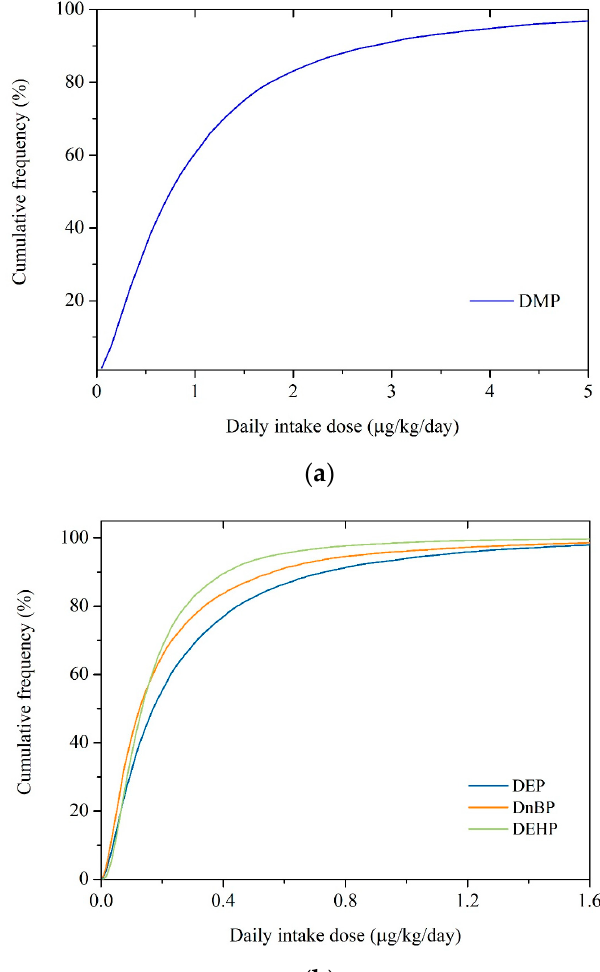
Figure 1. Cumulative frequency distribution of exposure to phthalates in dormitories. ( a ) DMP; ( b ) Other phthalates.